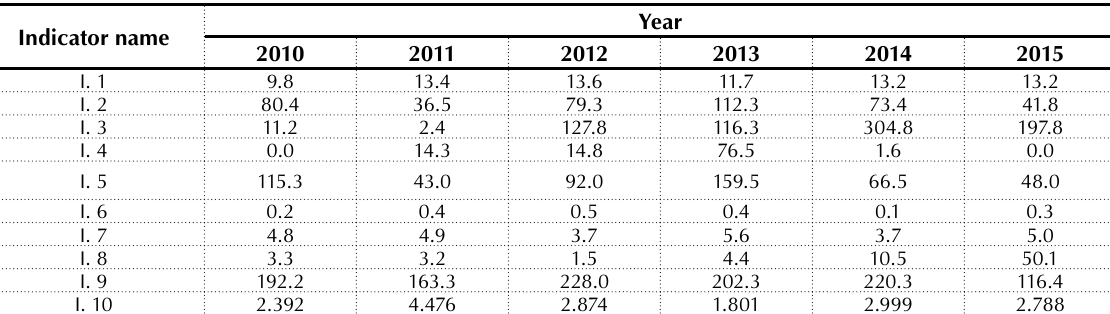
Table 1. The actual values of indicators of innovation activity of light industry companies in Ukraine